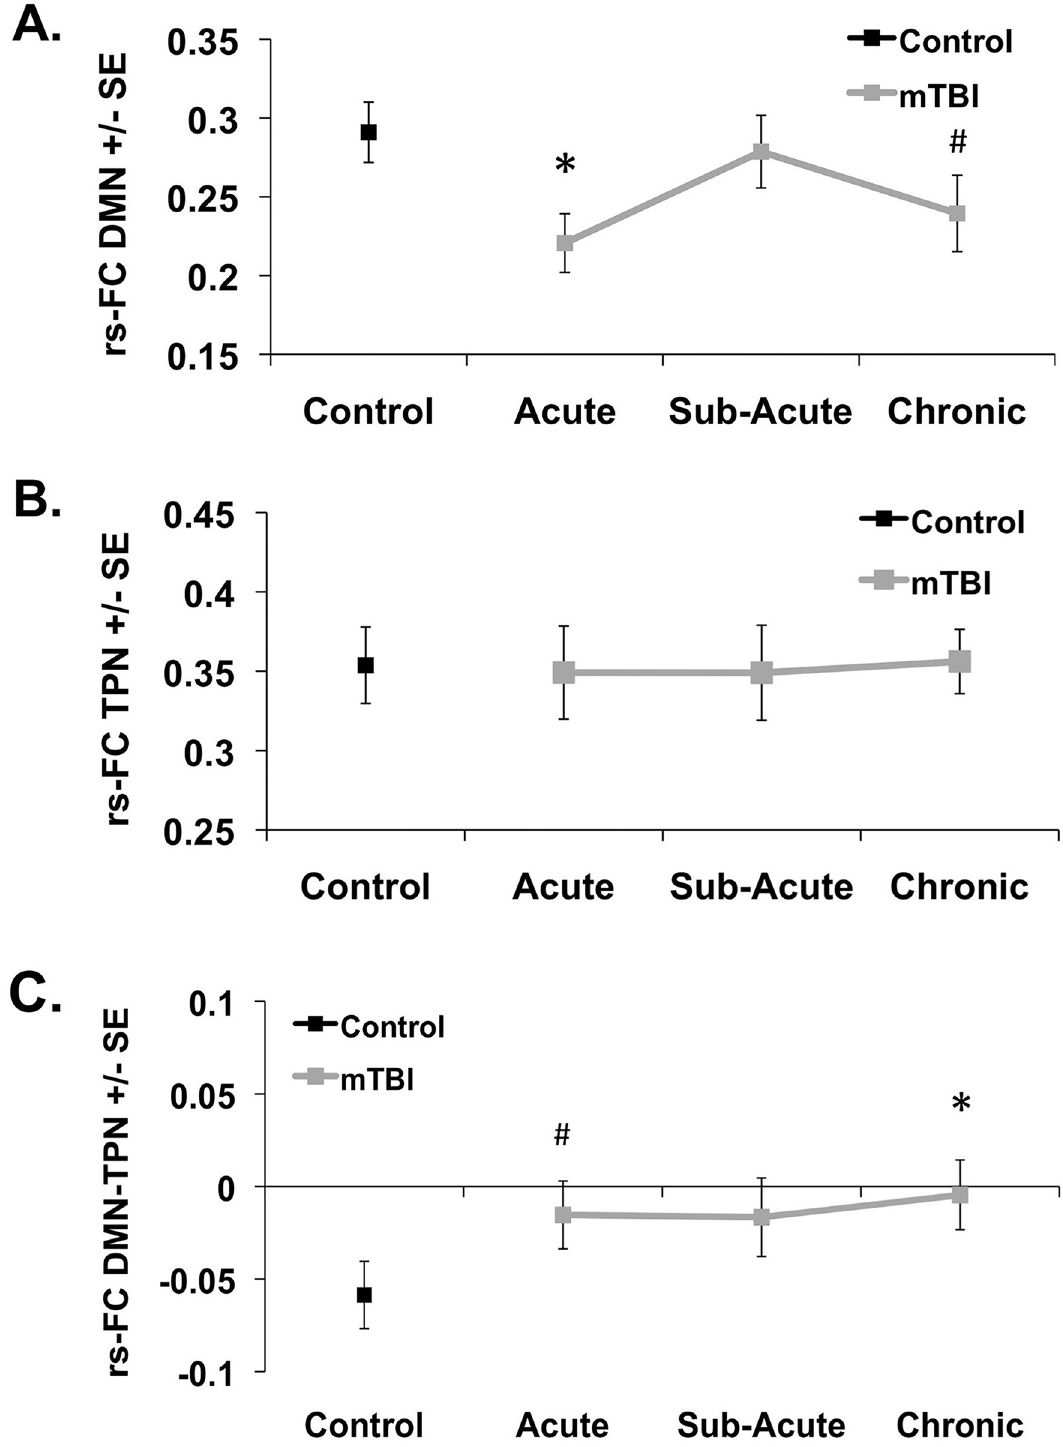
Fig 5. Plots of average network resting state connectivity strength. Plots of strength +/- standard error (SE) for control group and mTBI group across three time points. Average strength of network rs-FC for the (A) within Default Mode Network (rs-FC DMN) and (B) within Task Positive Network (TPN) (rs-FC TPN) and (C) between DMN and TPN (rs-FC DMN-TPN). # p < 0.1, * p < 0.05 compared to the control group based on analysis of covariance.